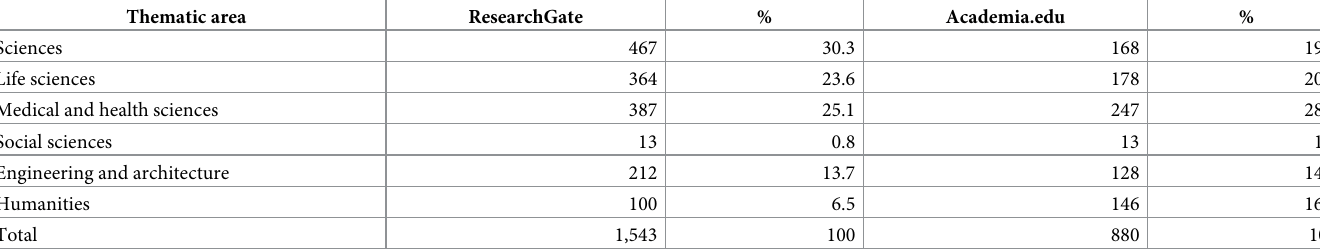
Table 13. Use of ResearchGate and Academia according to thematic area (copies found). Thematic